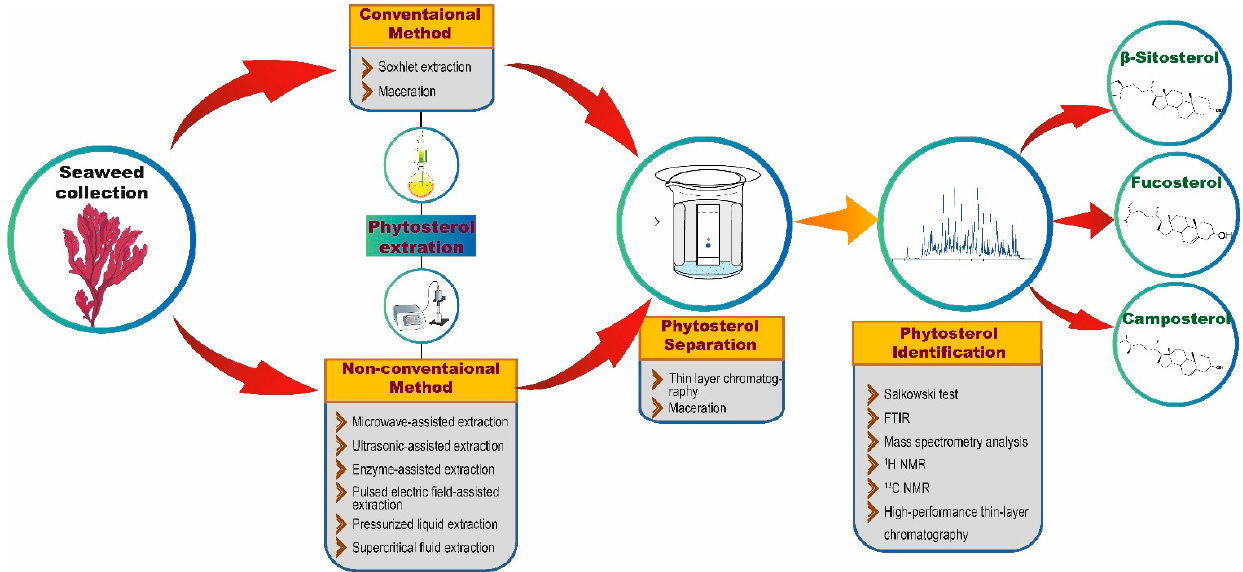
Figure 2. An overview of phytosterol extraction and characterization methods.